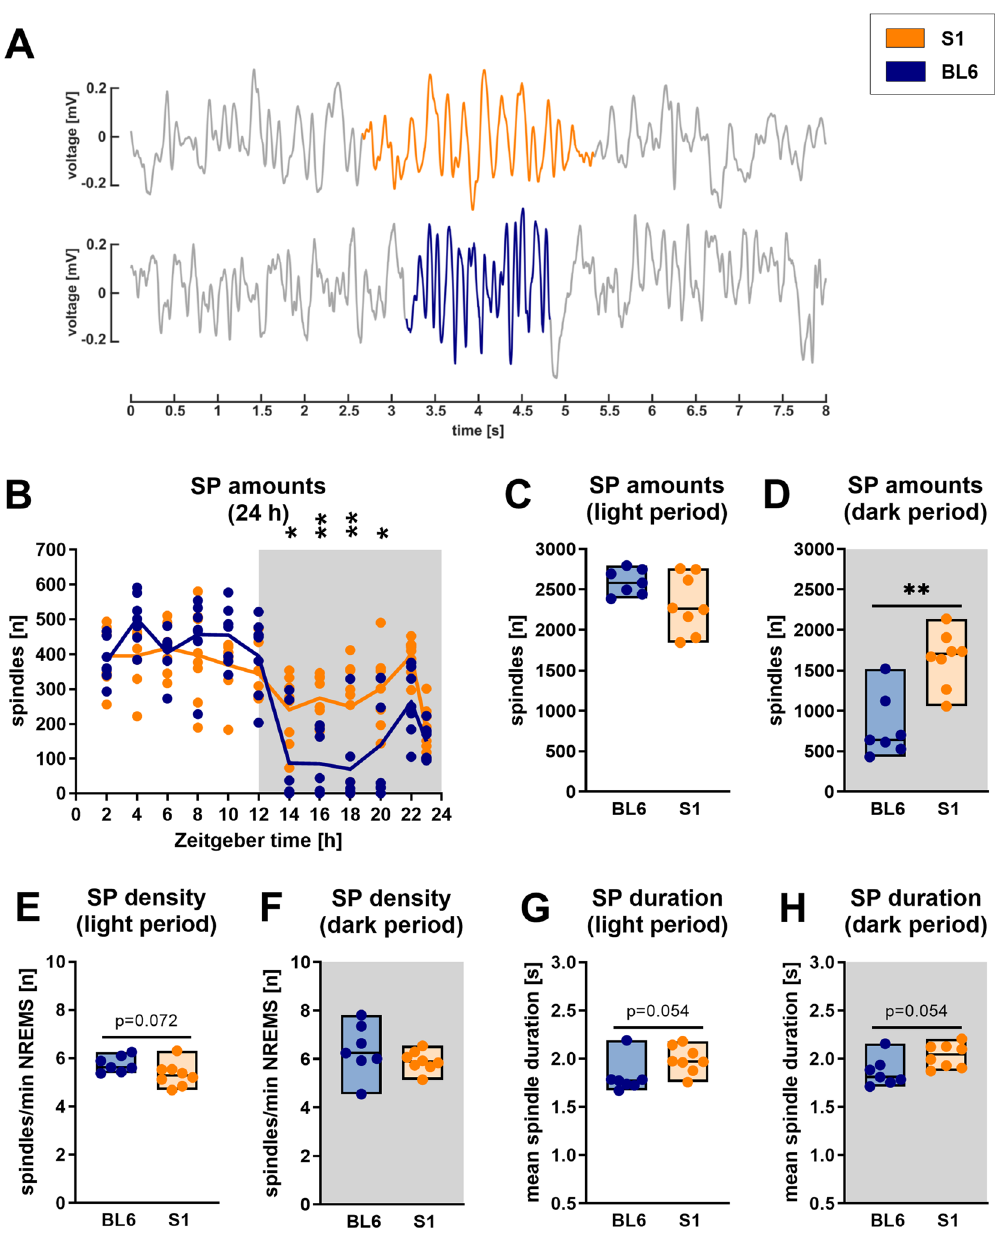
Figure 6. Sleep spindle (SP) detection in S1 (n = 8) and BL6 (n = 7) mice. Corresponding to increased NREMS percentages (Fig. 2B), also SP amounts were significantly higher in S1 than BL6 mice in the dark period [( B ) ‘strain’: p = 0.067, ‘time’: p < 0.001, ‘time × strain interaction’: p < 0.001; ( D ) p = 0.002]. The number of SP per minute of NREMS, however, was unaltered [( F ) p = 0.189]. In the light period, SP amounts did not differ between S1 and BL6 mice [( C ) p = 0.160], while a trend towards higher SP density was observed [( E ) p = 0.072]. Average SP duration, however, was (non-significantly) shorter in S1 than BL6 mice [( G , H ) p = 0.054]. ( A ) Representative examples of sleep spindles detected in raw EEG traces of a S1 and a BL6 mouse. ( B ) The graph shows 2 h means as lines plus individual data points, white and grey backgrounds indicate light and dark period. Statistical significance was determined by two-way RM ANOVA with one-factor repetition (Sidak post-hoc test). ( C – H ) All floating bars show min-to-max values with median and individual data points. Statistical significance was determined with a Mann–Whitney U test (*p < 0.05, **p <